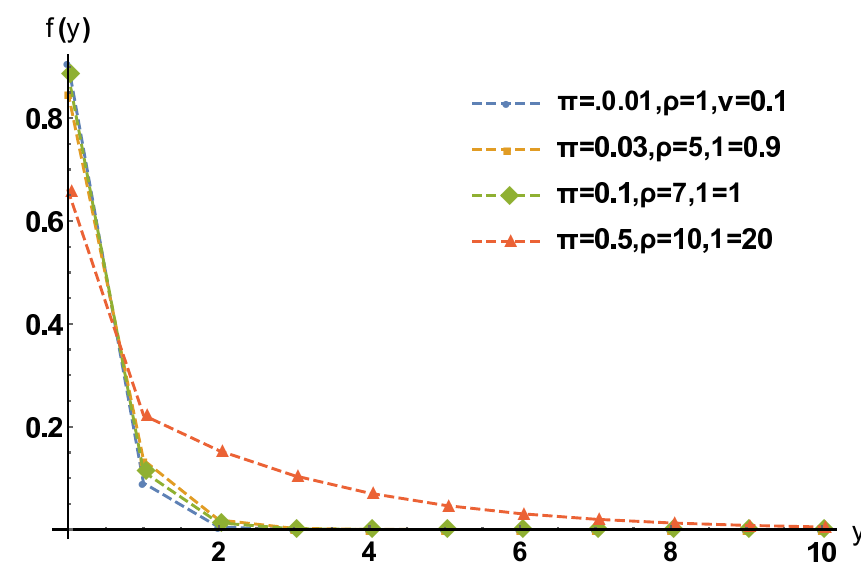
Figure 3 – Plots of probability mass functions of ZIAHPD for different values of ρ .